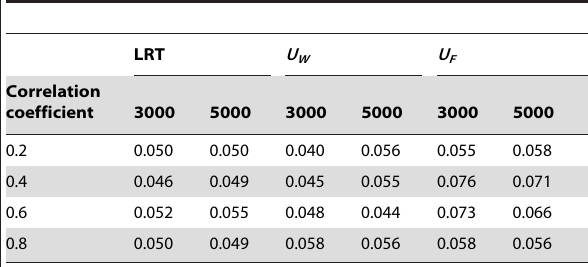
Table 2. Type I error for three statistics without main effects under sample size 3000 and